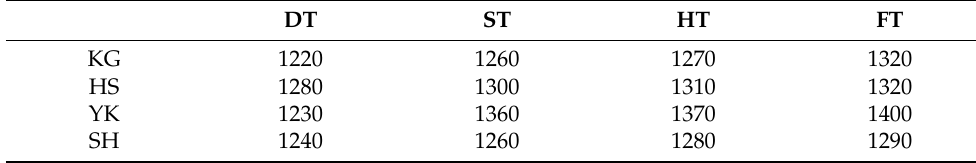
Table 4. Ash fusion temperatures of four low-rank coals (%).